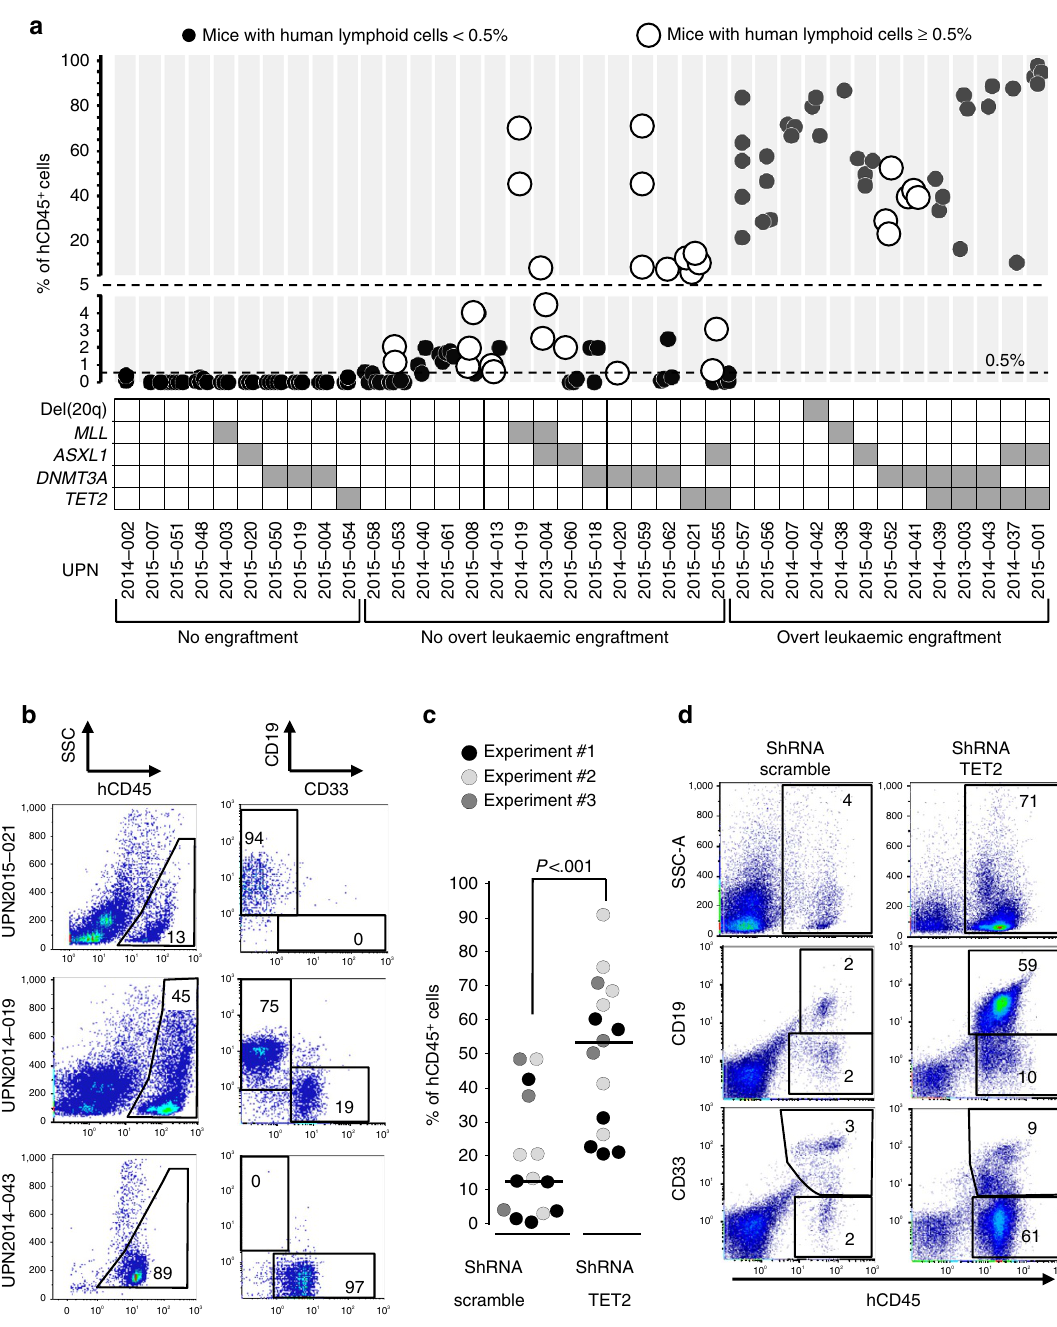
Figure 4 | AMLs with early epigenetic lesions have leukaemic and non-leukaemic repopulation capacities in NSG mice. ( a ) Percentages of human CD45 þ (hCD45 þ ) cells in the bone marrow of NSG mice 8–43 weeks after injection of 5 (cid:2) 10 6 mononuclear cells from 38 AML blood samples. The presence of candidate pre-leukaemic lesions in injected cells is indicated in the co-mutation table. ( b ) Flow cytometric analysis of NSG bone marrow repopulated with non-leukaemic (UPN2014-019, UPN2015-021) and leukaemic (UPN2014-043) cells. ( c ) Repopulation of NSG bone marrow by shRNA TET2 or scramble transduced cord blood CD34 þ cells. Bars indicate the median (Mann–Whitney test). ( d ) Flow cytometric analysis of the bone marrow from two representative mice transplanted with control (shRNA scramble) and TET2 knocked-down (shRNA TET2) cells.